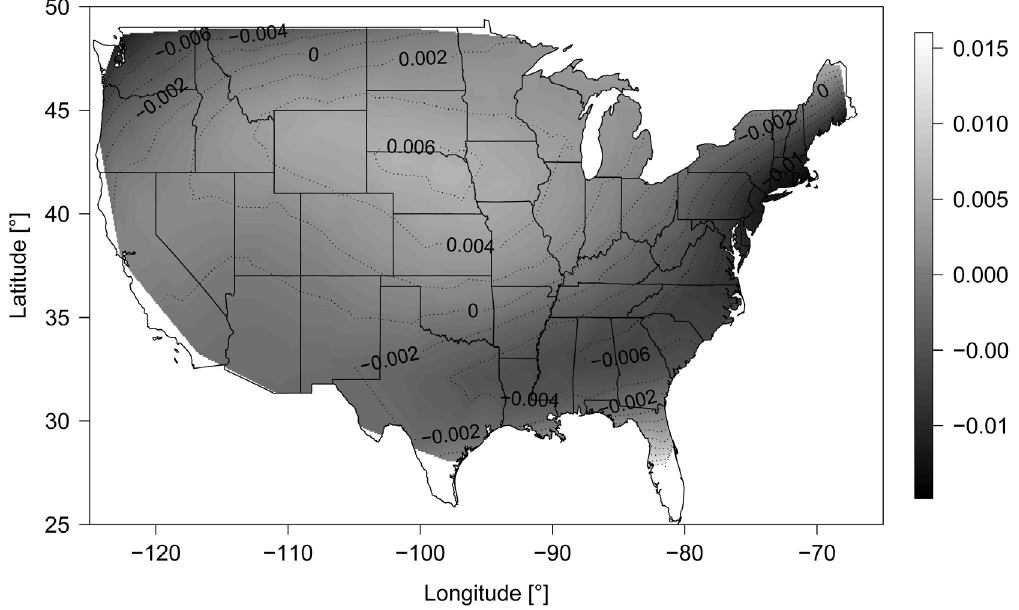
Figure 12. Estimated spatial surface function. Estimated spatial surface function f sp,mean ( X Lon , X Lat ) for the mean parameter m in boosted beta regression. The figure presents the median spatial surface obtained from the 100 bootstrap samples.